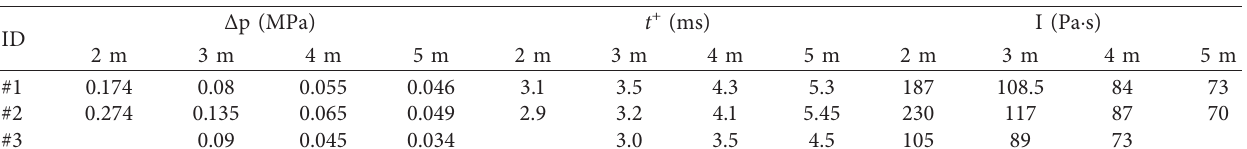
Figure 11: Time-dependent variation curves of shock wave overpressure: (a) witness board #1, (b) witness board #2, and (c) witness board #3. Table 4: Measurement results of shock wave overpressure and positive pressure acting